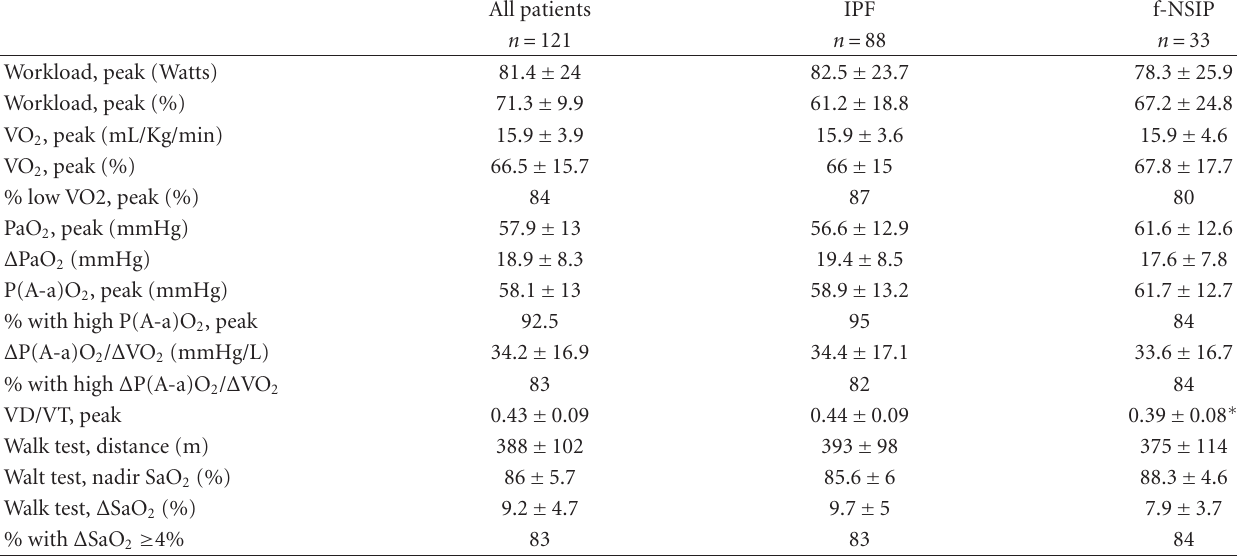
Table 2: Cardiopulmonary exercise testing and walking test results. All